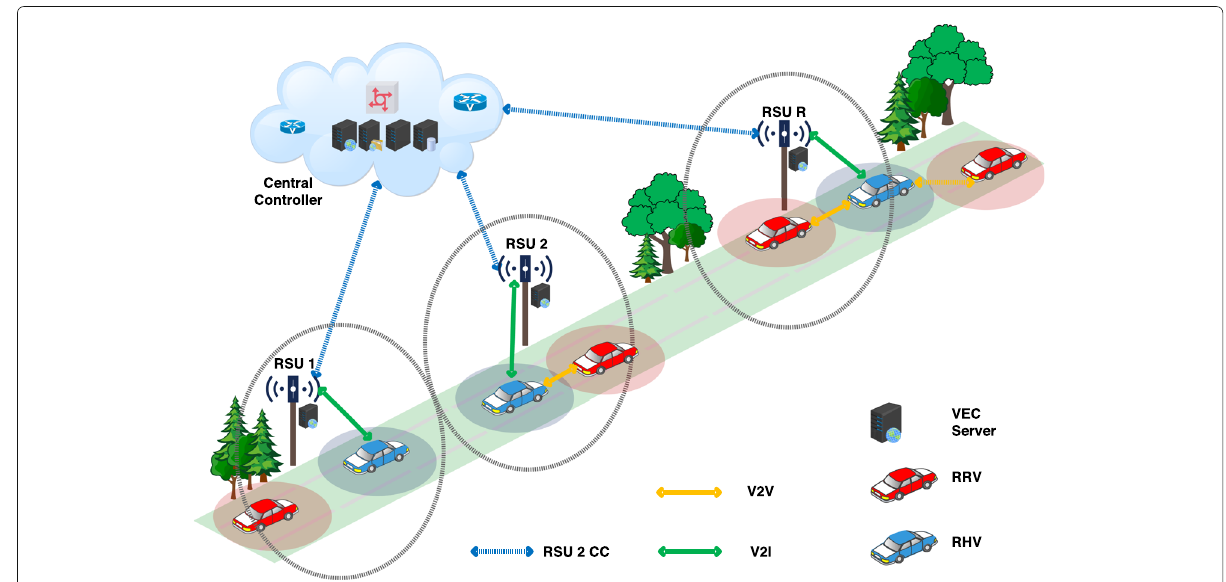
Fig. 1 Task offloading scenario in Vehicular Edge Computing